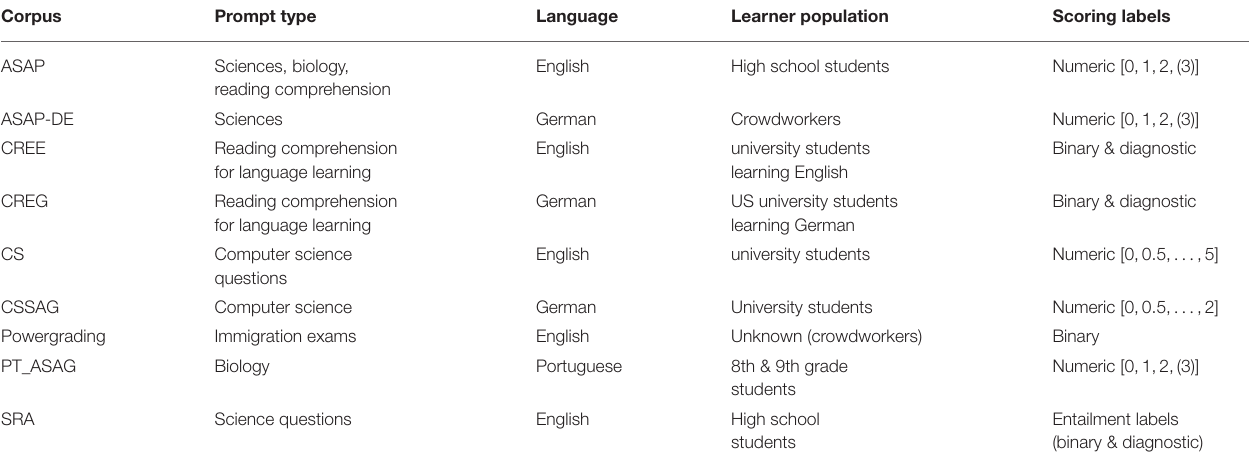
TABLE 2 | Overview of content scoring